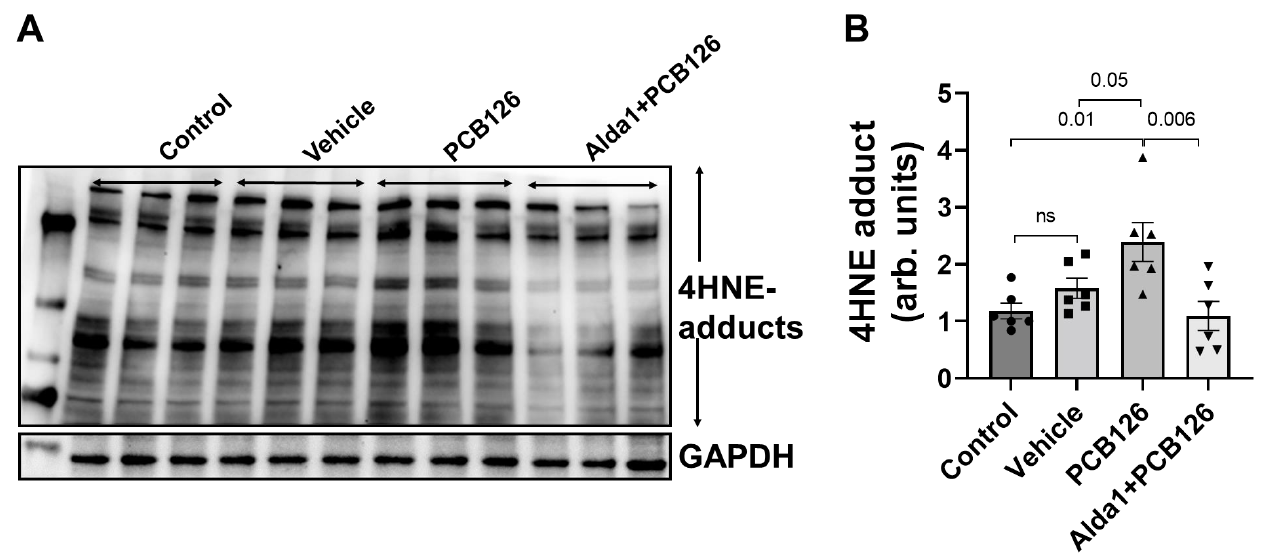
Figure 5. The 4HNE protein adduct levels in PCB 126 and/or Alda 1-treated MCECs. ( A ) Representative WB band image of the 4HNE protein adducts after 24 h of PCB 126 treatment. ( B ) Quantification of the WB data in ( B ). n = 6 for each group. Each bar represents the mean ± SEM. PCB, polychlorinated biphenyl; ns, not significant.